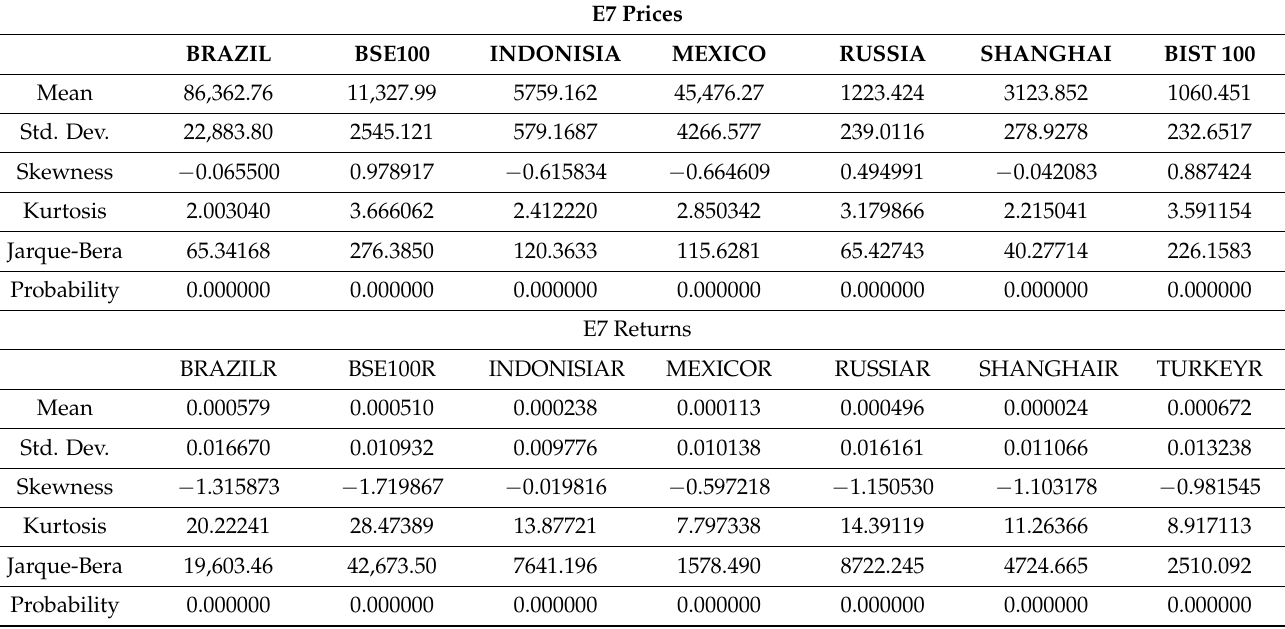
Table 2. E7 Descriptive